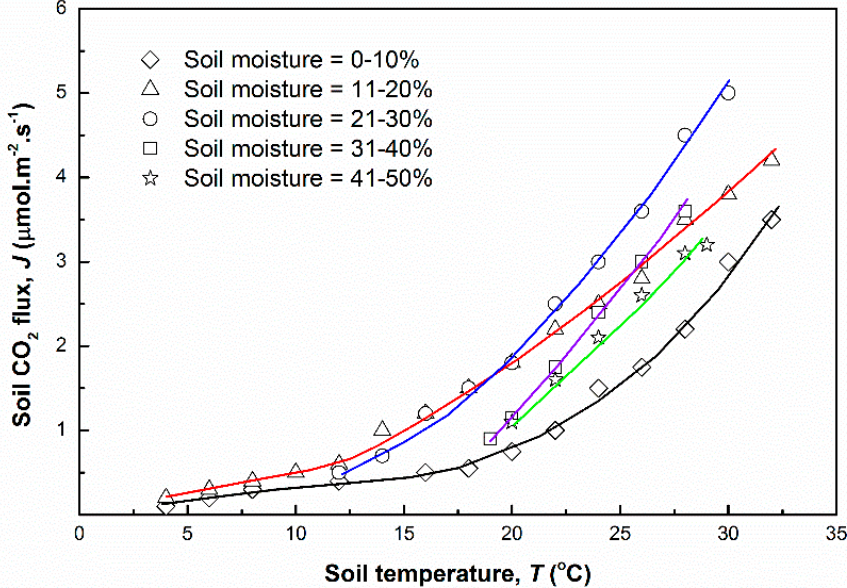
Figure 12. Soil CO 2 flux ( J ) and soil temperature ( T ) across various soil moisture levels, recorded at Location A (Dec 5, 2016 to Oct 9, 2017).